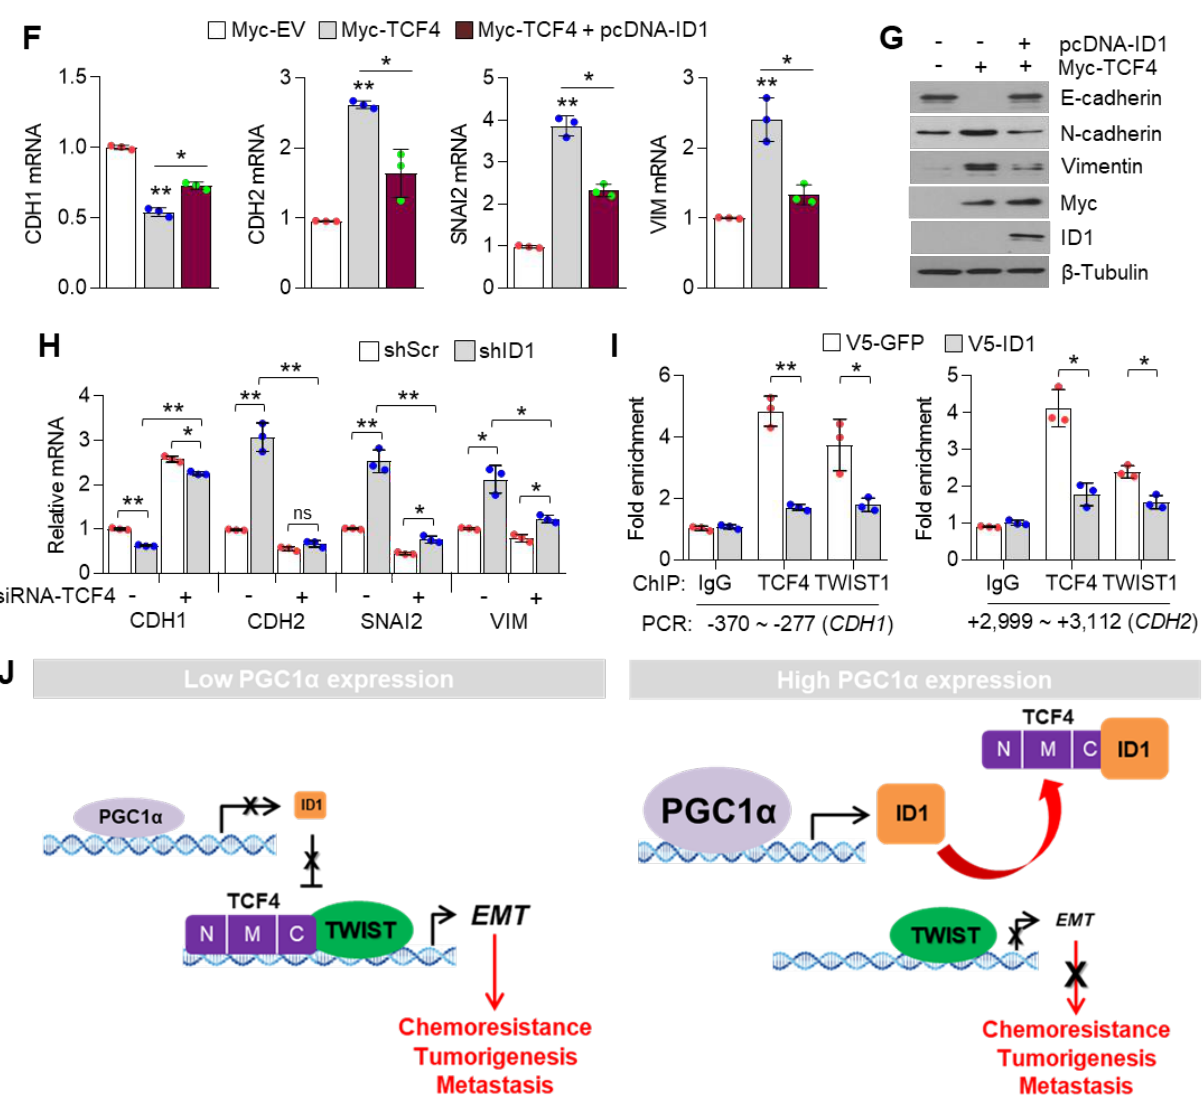
Figure 7. ID1 inhibits the interaction and transcriptional activity of TCF4 and TWIST1. ( A ) The protein–protein interaction of ID1 and TCF4. Interaction between TCF4 and ID1 was analyzed using co-immunoprecipitation and Western blotting. ( B ) ID1 interacts with the C-terminal region of TCF4. ( C ) Interaction between TCF4 and TWIST1 upon ectopic ID1 expression was analyzed by co-immunoprecipitation and Western blotting. The levels of TCF4 protein, which binds to TWIST1, was quantified by using image J. ( D ) In vitro protein–protein interaction analysis using recombinant proteins. Interaction between TCF4 and TWIST1 was measured by co-immunoprecipitation using anti-TCF4 or anti-IgG antibodies and Western blotting. ( E ) Endogenous TCF4 and TWIST1 interaction in PGC1α-silenced A549 cells. ( F , G ) Expression of the EMT genes ( F ) and proteins ( G ) in A549 cells expressing Myc-EV or Myc-TCF4 with or without pcDNA-ID1 as indicated ( n = 3). ( H ) Expression of the EMT genes in A549 cells ( n = 3). ( I ) ChIP for TCF4, TWIST1, and IgG followed by ChIP-qPCR in PGC1α knocked-down A549 cells transfected with GFP and ID1 ( n = 3). ( J ) Graphical summary of the proposed molecular mechanism by which decreased PGC1α suppresses ID1, and consequently increases TCF4-TWIST1-mediated EMT. Conversely, high levels of PGC1α expression-induced ID1 result in suppression of EMT by interfering the interaction between TCF4-TWIST1. Black and red arrows represent the positive effect, ┴ line represents the negative effect,and X represents the suppressive effect on the proposed working model. Values represent mean ± SD. ns, not significant; * p < 0.05 and ** p < 0.01 by Student’s t -test. The whole western blot images are showed in Figure S7.